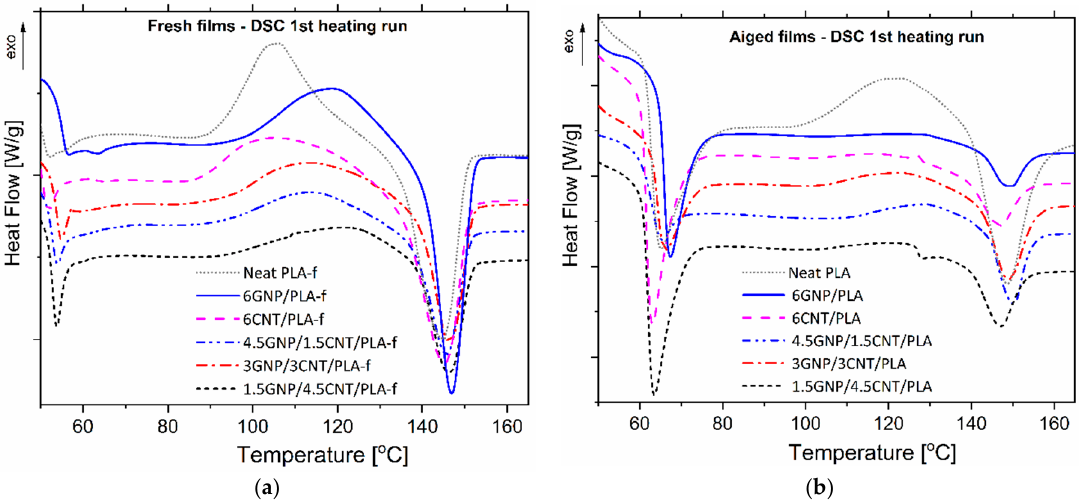
Figure 3. Differential scanning calorimetry (DSC) thermograms in the first run at a heating rate of 20 °C/min for the PLA and 6 wt.% composite films, varying the filler combinations. Comparison between: ( a ) freshly prepared films, and ( b ) aged films after 18 months of storage.